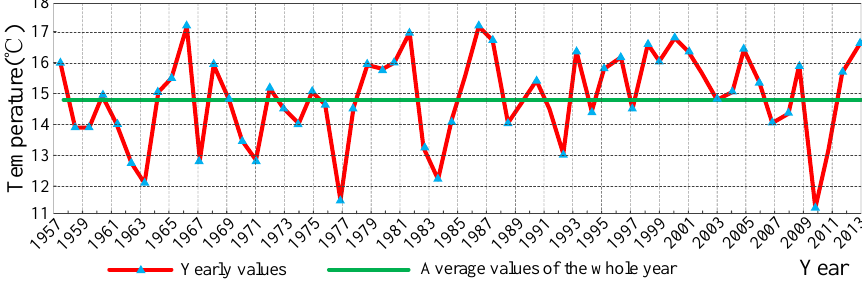
Figure 5. Average temperature curve of South China Jiangmen city in January from 1957 to 2013.